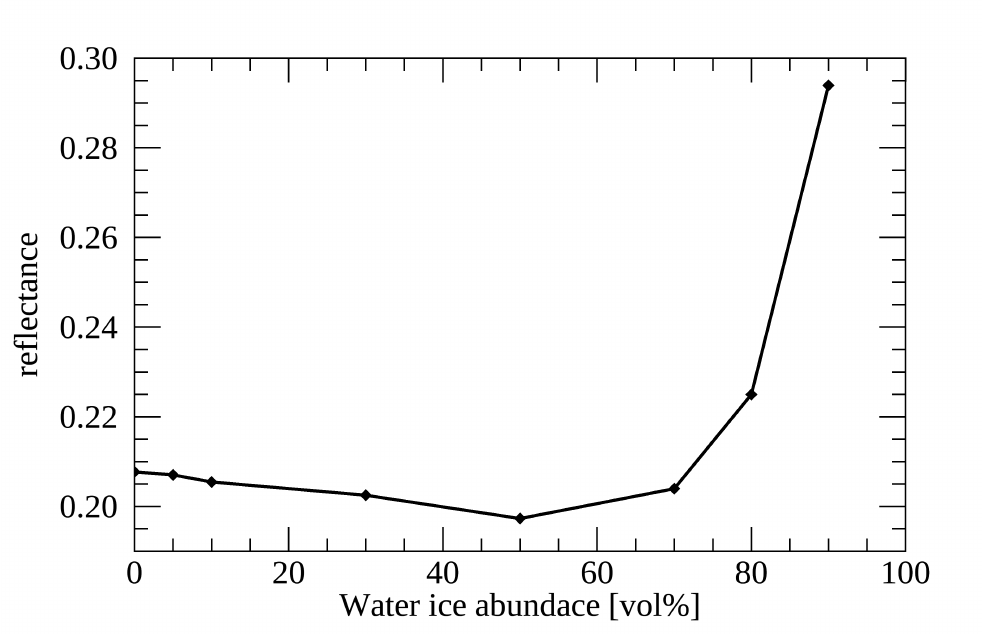
Figure A2. Reflectance at 0.7 µ m of water ice–pyrrhotite intimate mixtures from Monte Carlo ray-tracing simulations as a function of water ice volumetric abundance in the